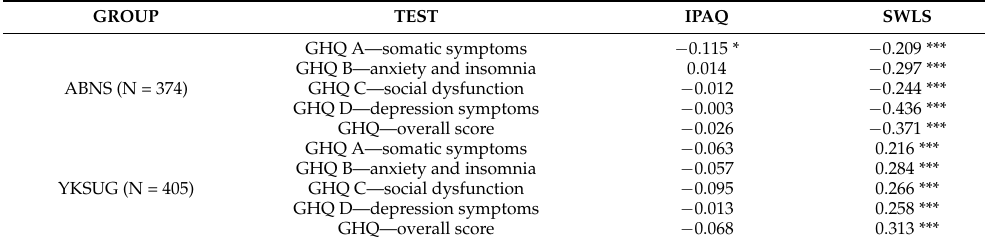
Table 6. Correlations between the evaluation of mental health state of the respondents and their PA levels and satisfaction with life during COVID-19 pandemic (Spearman’s